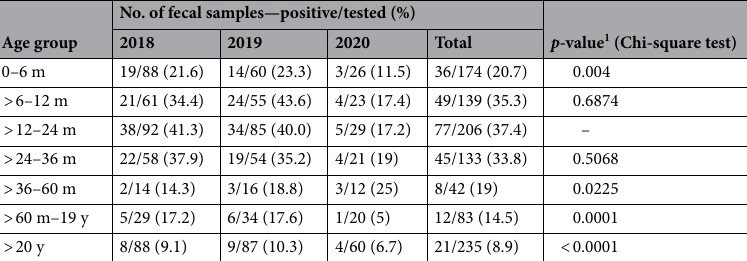
Table 3. Number of tested and HAdV-positive fecal samples through laboratory-based surveillance by age group in Brazil during 2018–2020. m months old, y years old. 1 p -values were calculated between the age group of > 12–24 m and each